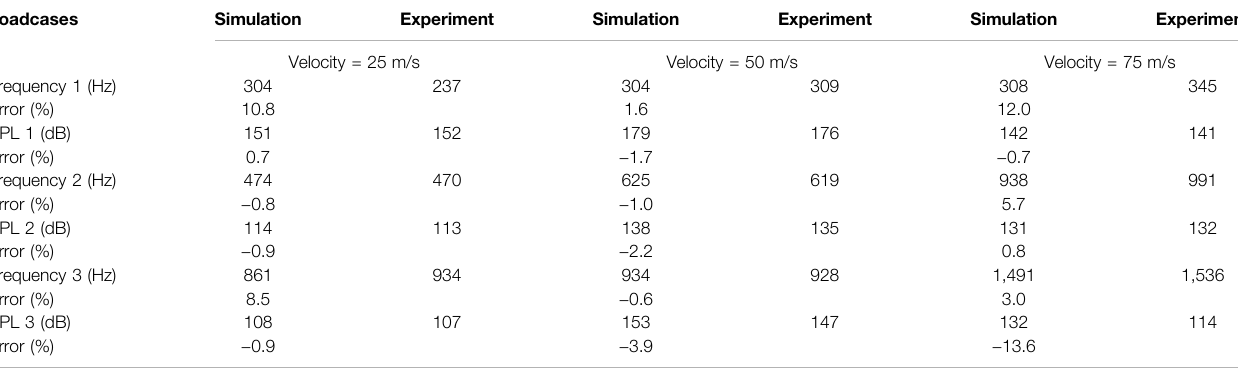
TABLE 2 | Frequencies and SPL ofacoustic resonance comparison between simulation and experiment when the diameter (without chamfer) and height ofthe branchpipe were 60 and 250 mm, respectively.